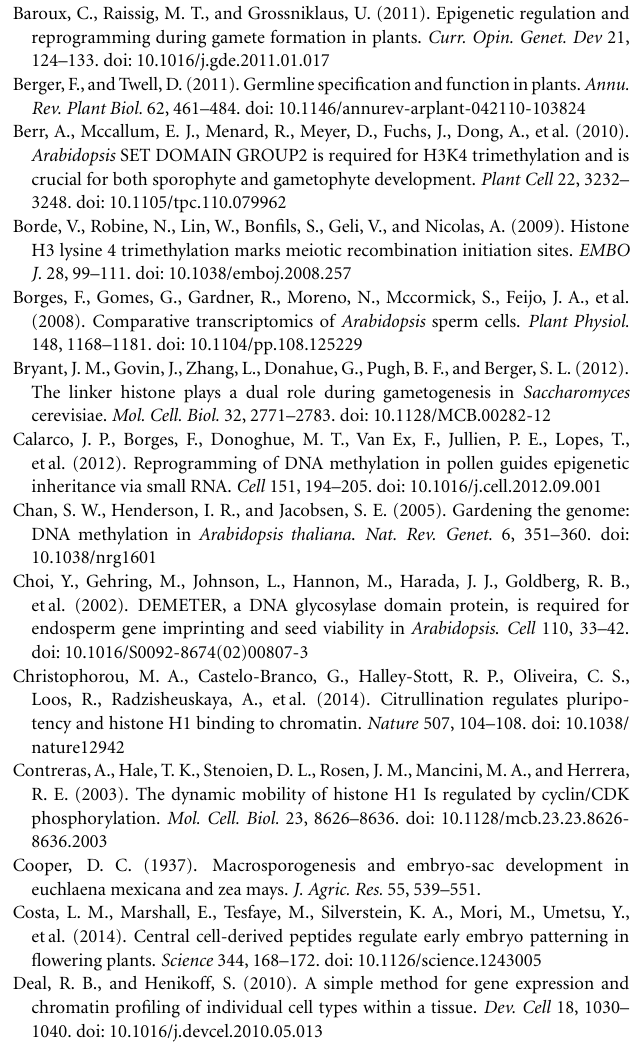
Fertilization enables the formation of a totipotent zygote, generating in turn the plant embryo.The acquisition of the SMC fate, the gametic fate and the totipotent zygotic fate is associated with three main waves of chromatin dynamics (I.–III., colored nuclei) comprising large-scale reorganization of the chromatin structure, composition and organization, hence reshaping the epigenetic landscape (as reviewed in the text).Whereas some of those events clearly contribute to cell fate establishment (e.g., I., see the text), the challenge of future investigations is to elucidate the functional role of chromatin dynamics in defining the cells’ potency versus operating cell fate establishment during sexual